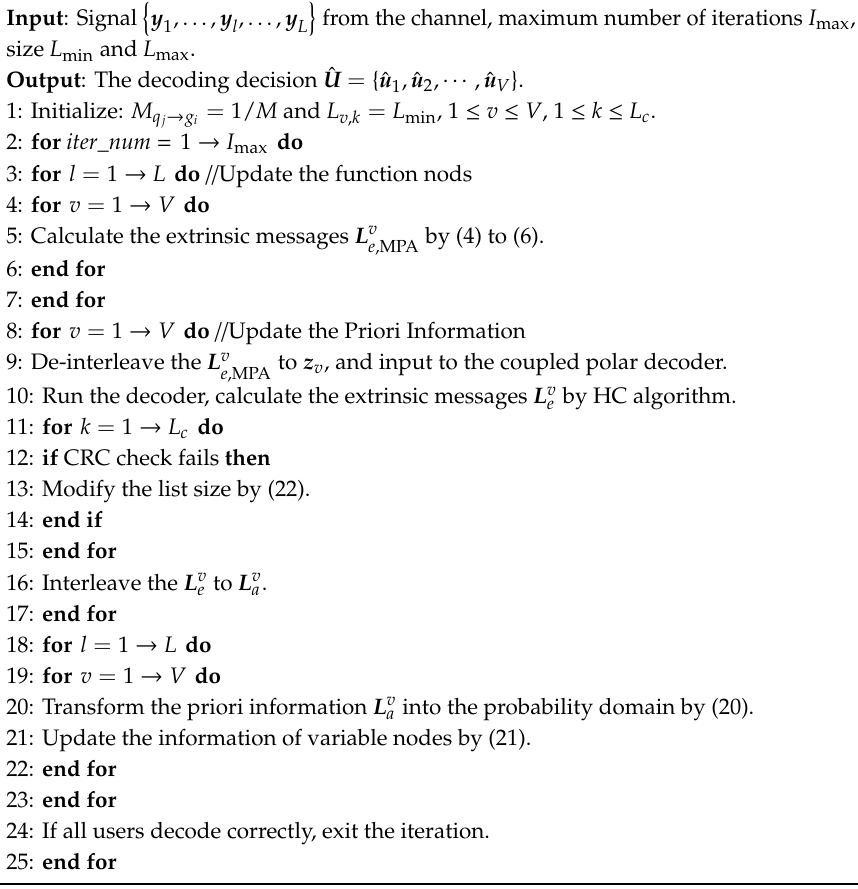
Algorithm 3 Joint iterative detection and SCL